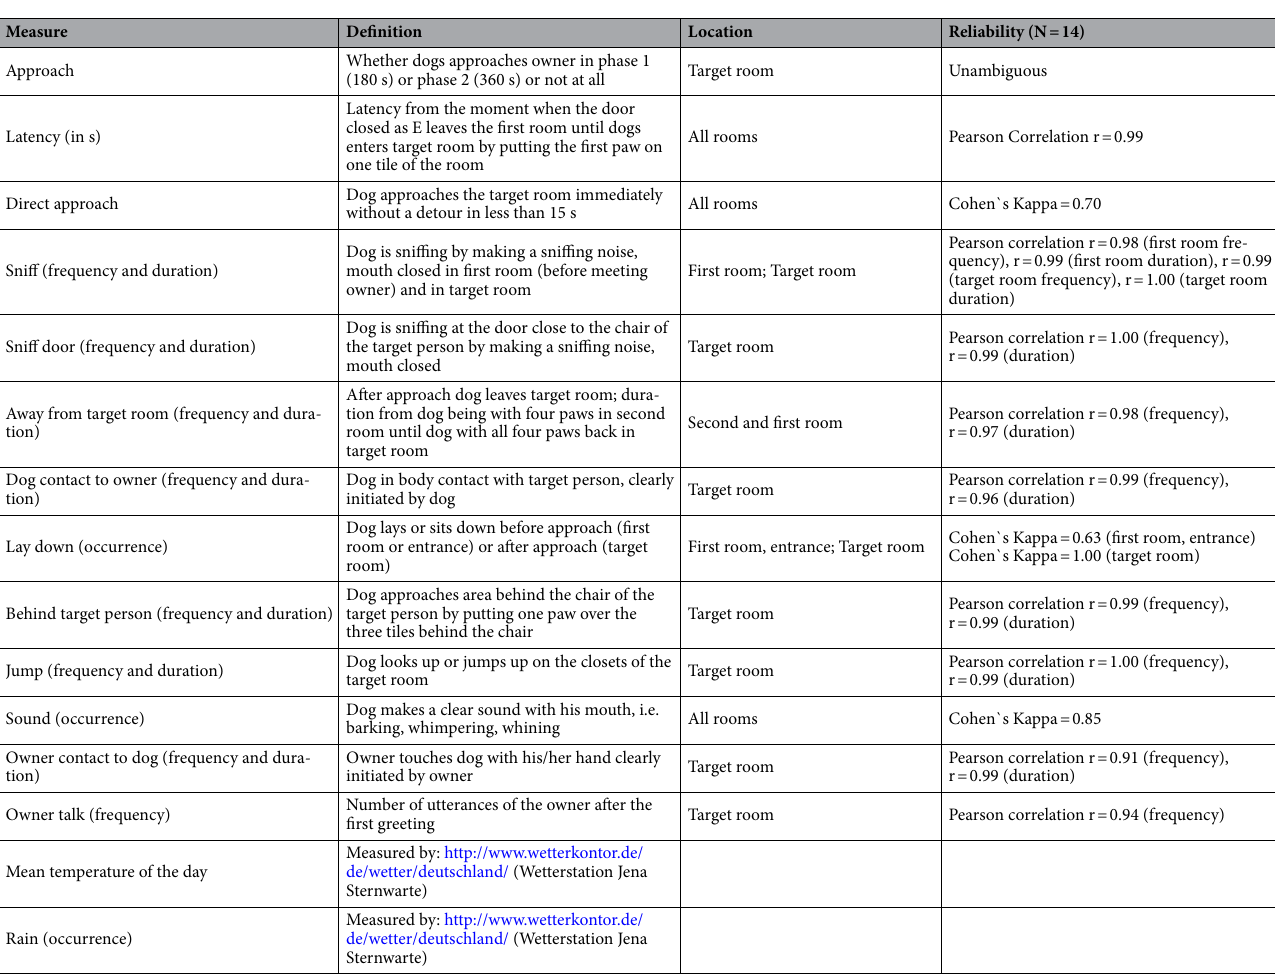
Table 2. Summarizes the coding measures and the